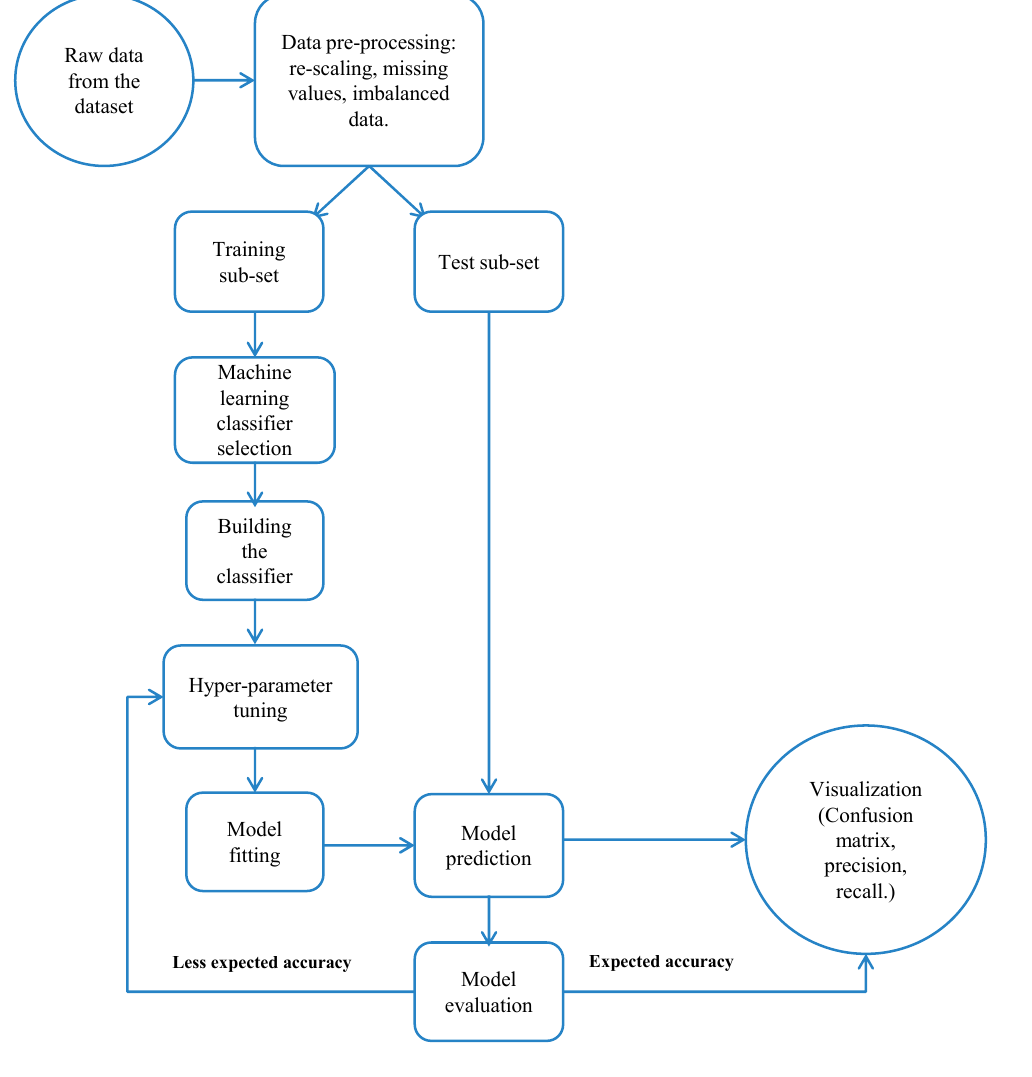
Figure 1. Flow chart for Machine Learning (ML) methodology